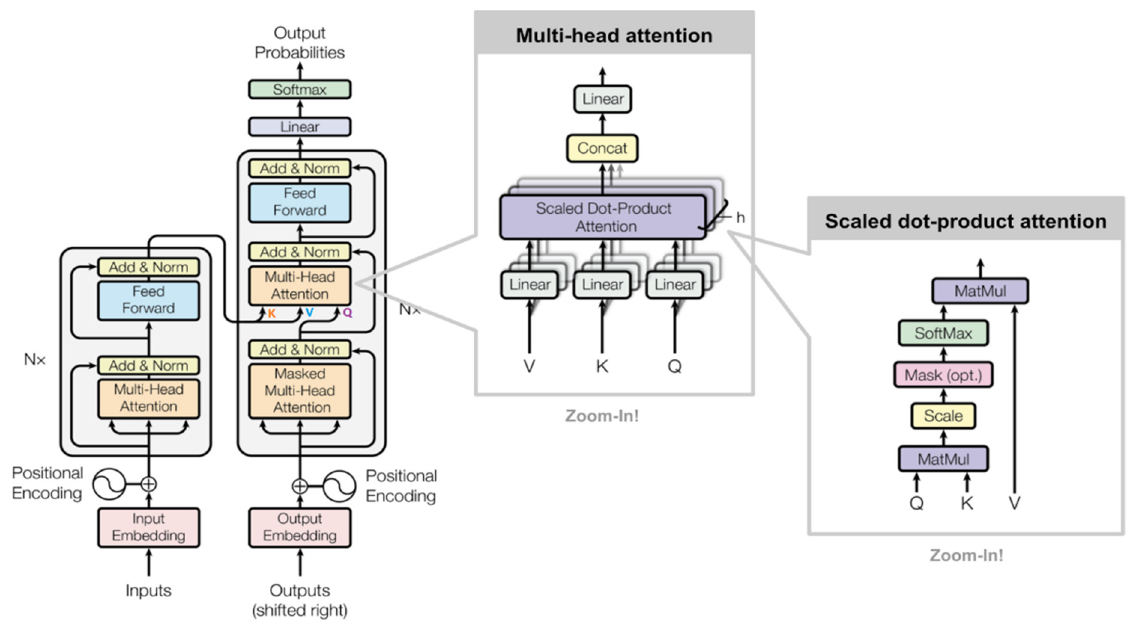
Figure 4. The transformer model’s architecture.